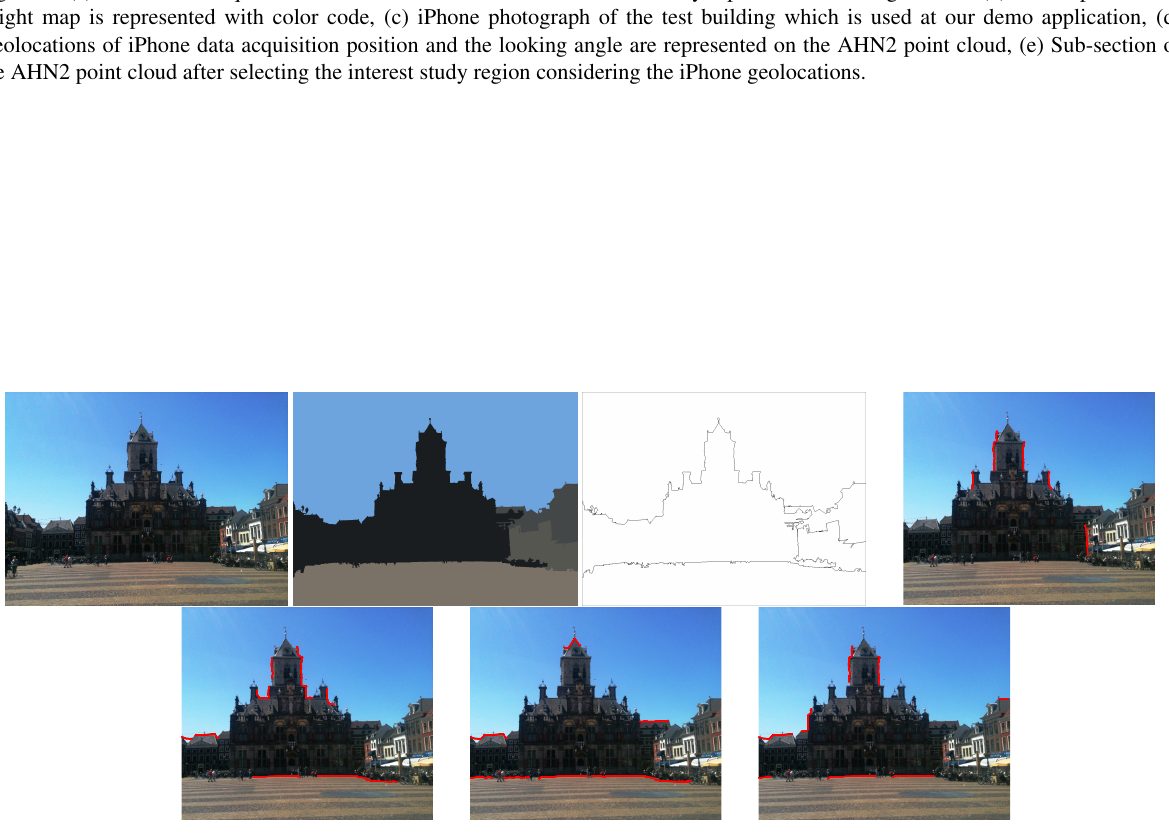
Figure 6: (a) Original iPhone photo of the interested building, (b) Mean-shift segmentation result, (c) Borders of the object segments, (d) Shape features obtained at θ = 0 filtering direction, (e) Shape features obtained at θ = π/ 4 filtering direction, (f) Shape features obtained at θ = π/ 2 filtering direction, (g) Shape features obtained at θ = 3 π/ 4 filtering